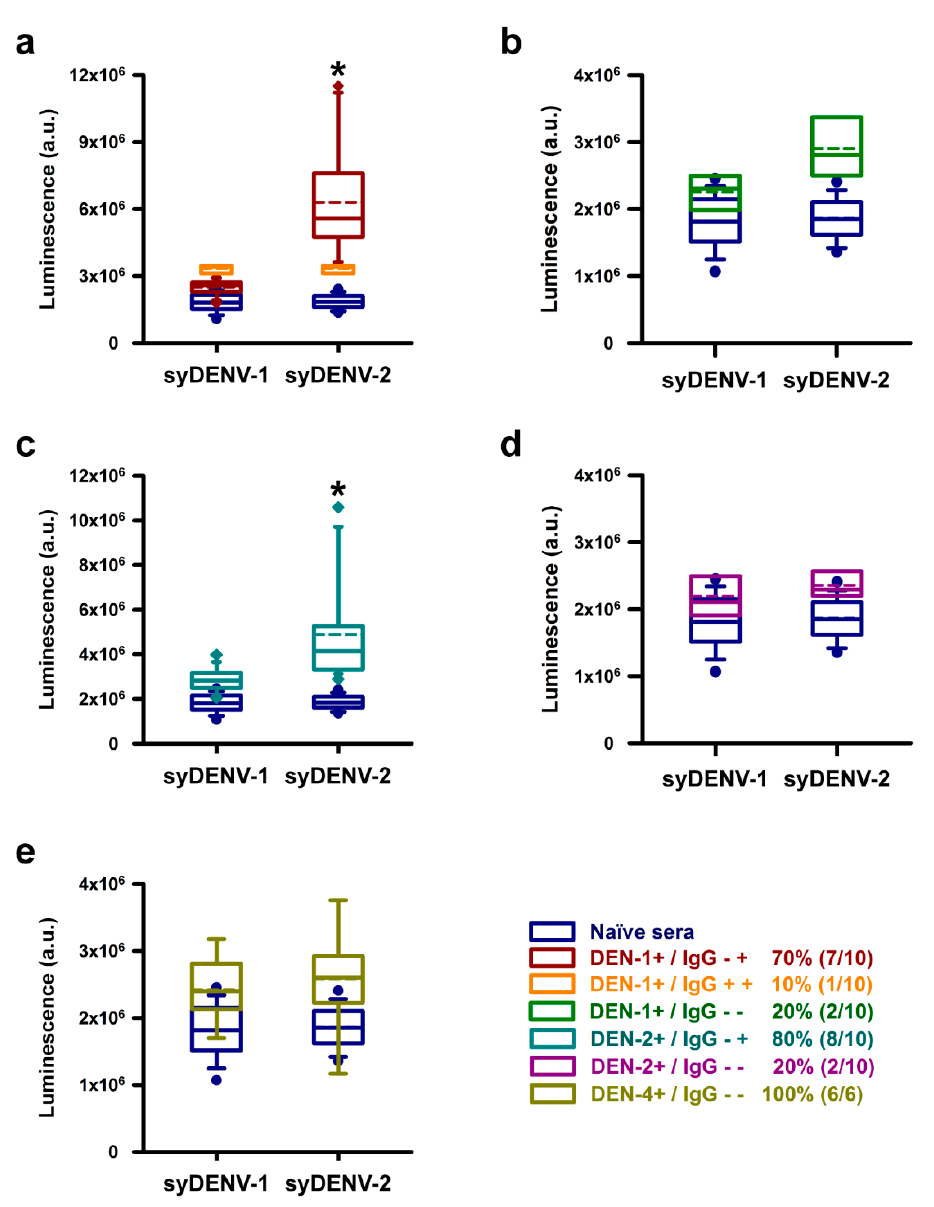
Figure 5. Reaction of sera from PCR-serotyped DENV-infected patients against the synthDENVElope proteins. Three panels of sera from NS1-IgG + seroconverted patients that were previously serotyped by molecular methods were tested against the synthDENVElope proteins. Sera from confirmed DENV-1 infections were able to generate higher levels of luminescence against the syDENV-2 than against the syDENV-1 protein (dark red boxes in a ), and one of the samples (orange boxes in a ) reacted against both syDENV-1 and -2, generating higher luminescence signals than naïve sera in these tests (dark blue boxes in all panels). Two of these sera did not generate luminescence levels above those of the naïve sera ( b ). The sera from confirmed DENV-2 patients recognized only the syDENV-2 but not the syDENV-1 protein (cyan boxes in c ). Two of these samples did not react against any of the syDENV proteins (magenta boxes in d ). None of the sera from a panel of confirmed DENV-4 infections reacted against any of the synthetic DENV E proteins (golden boxes in e ). * denotes p < 0.01 vs. all other groups.